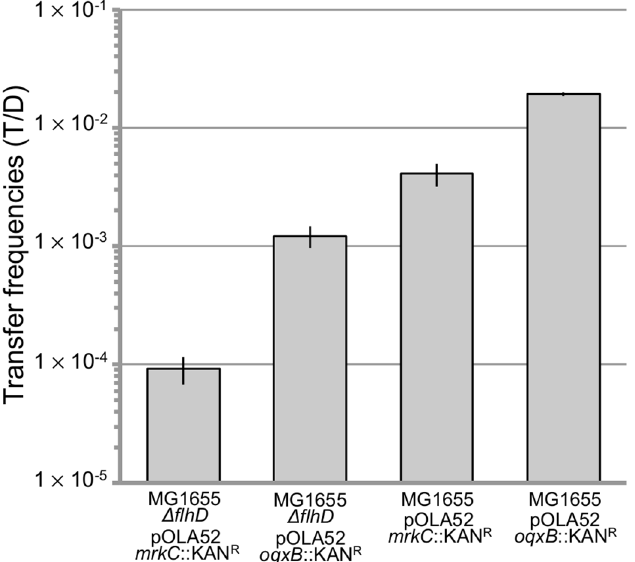
per donor (D). Δ flhD : non-motile E . coli MG1655 flhD deletion mutant unable to synthesize flagella. MG1655: motile E . coli MG1655. pOLA52- oqxB :: KAN R : type 3 fimbriae positive plasmid. pOLA52- mrkC :: KAN R : type 3 fimbriae negative plasmid. Each transfer frequency was different from the other (Error bars denote ± SEM, n = 3).